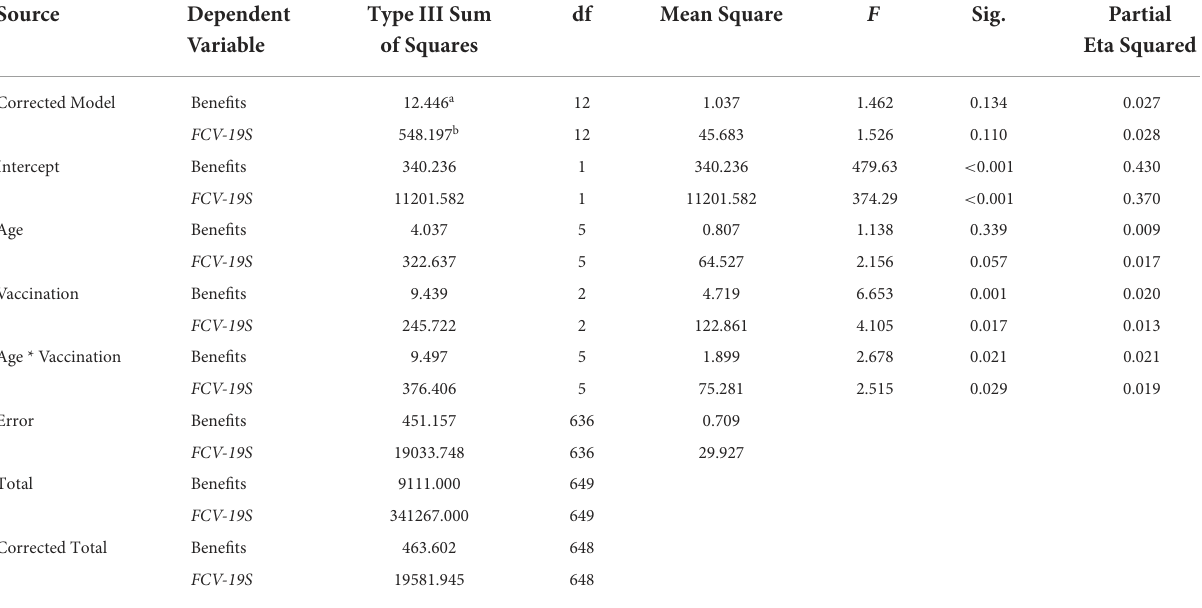
TABLE 2 Combined univariate ANOVA.